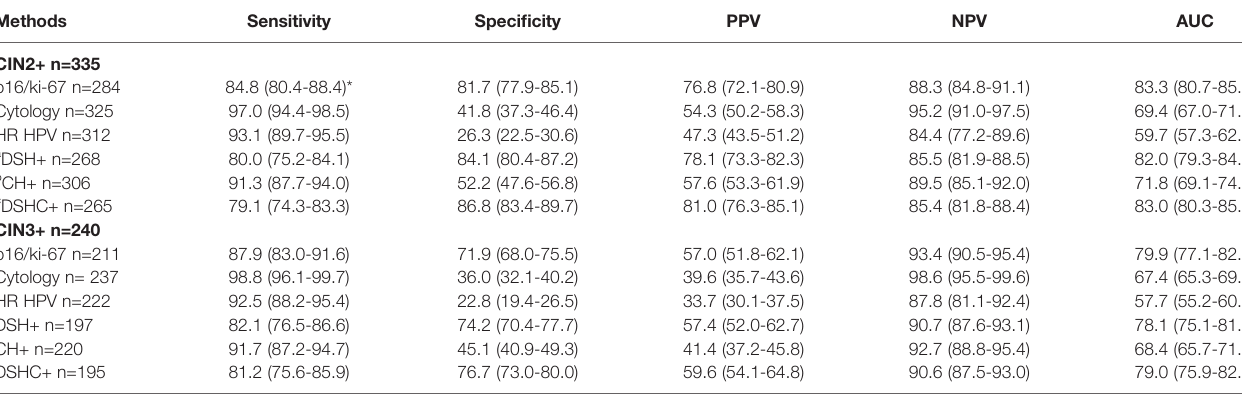
TABLE 3 | Performance of p16/ki-67 dual-staining, cytology and HR HPV testing in detection of CIN2+ or CIN3+. Methods